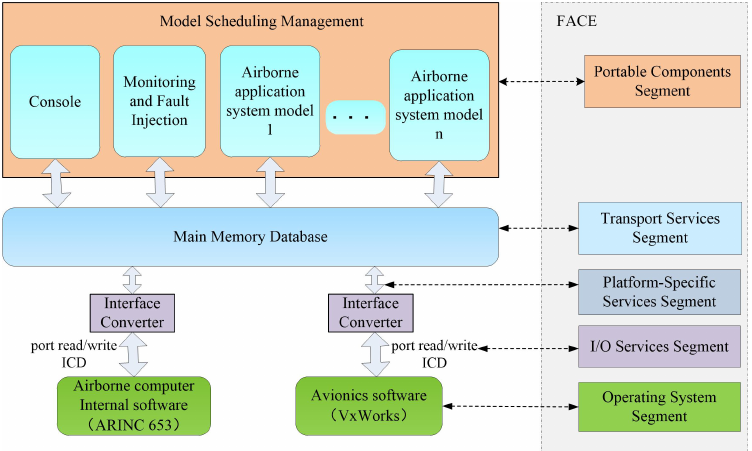
Figure 2. Architecture of simulation and verification platform for avionics